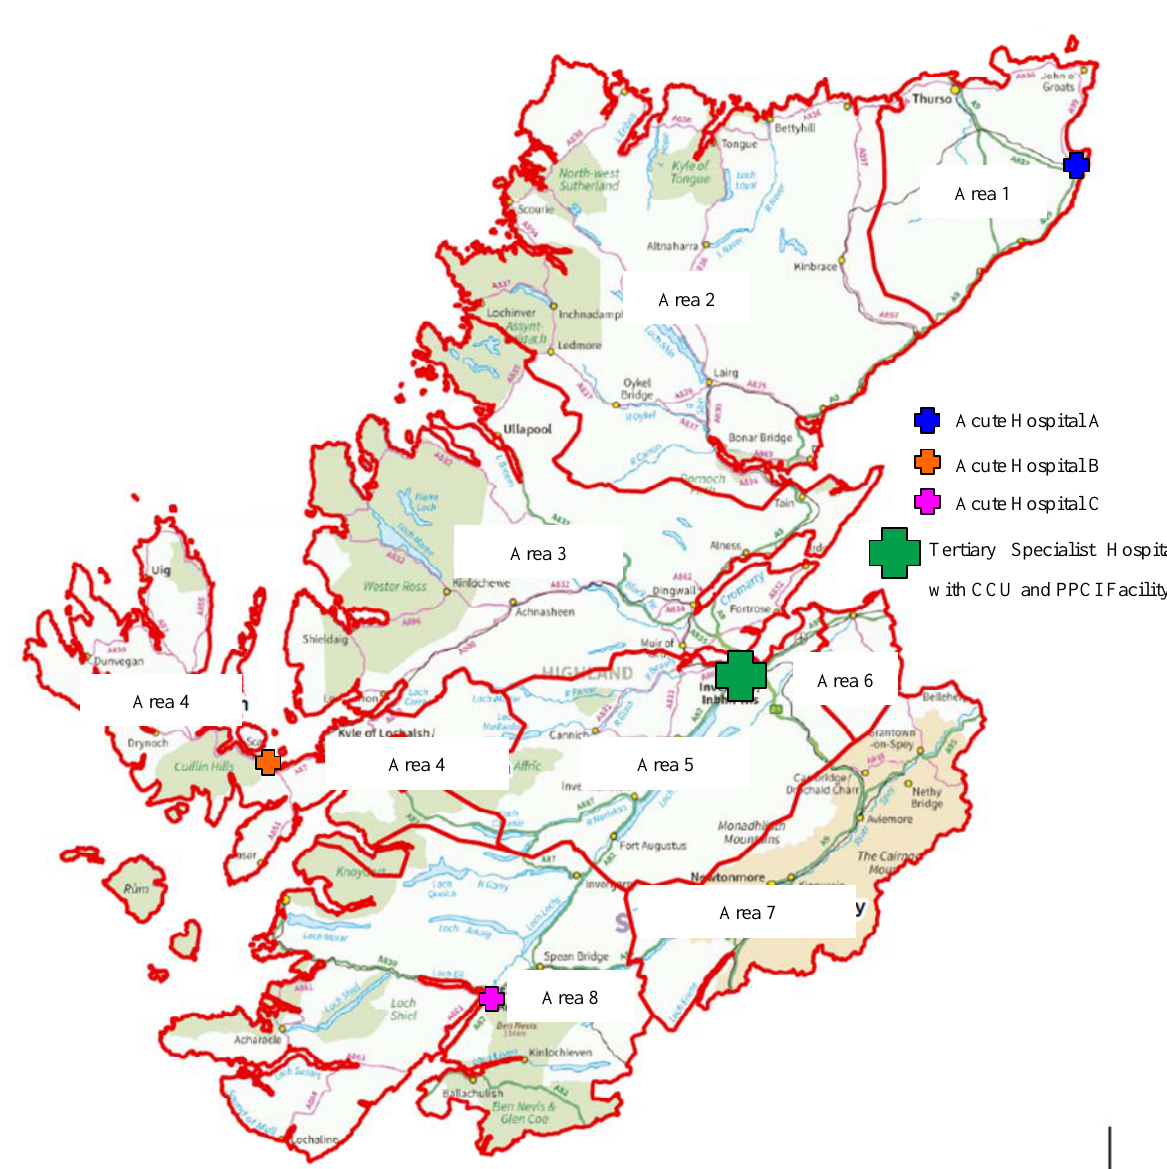
Figure 3. Map of Highland areas and acute